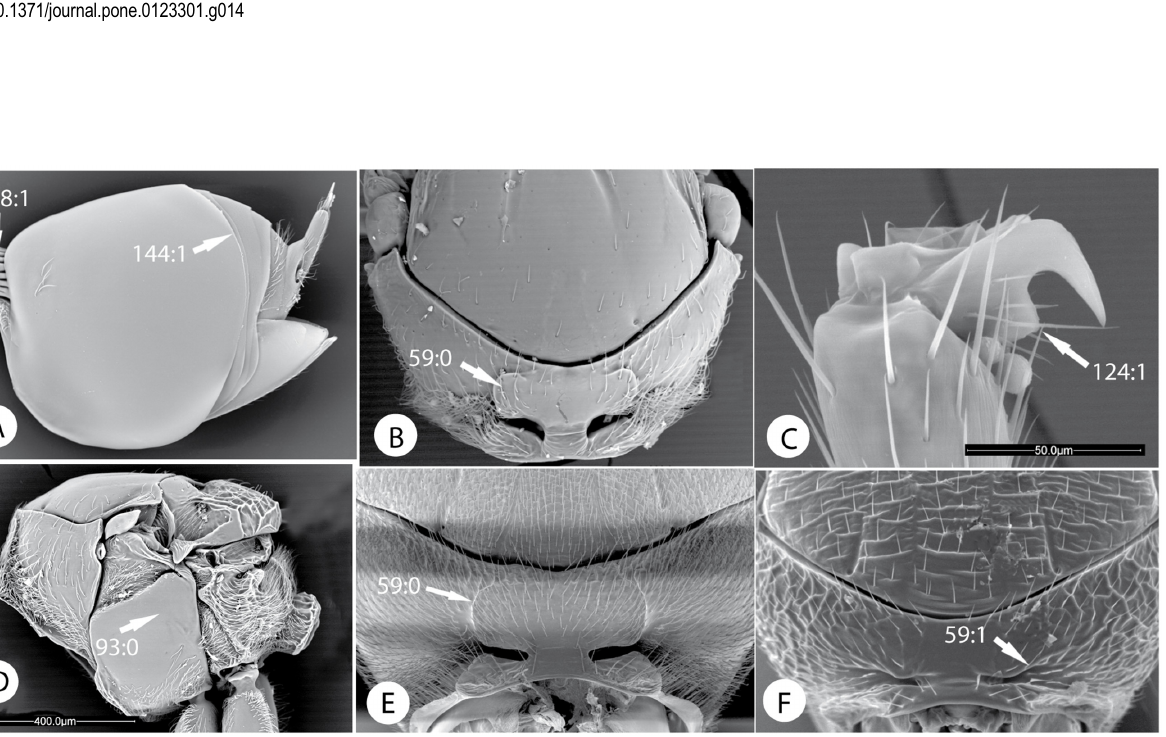
PLOS ONE | DOI:10.1371/journal.pone.0123301 May 20, 2015 27 /